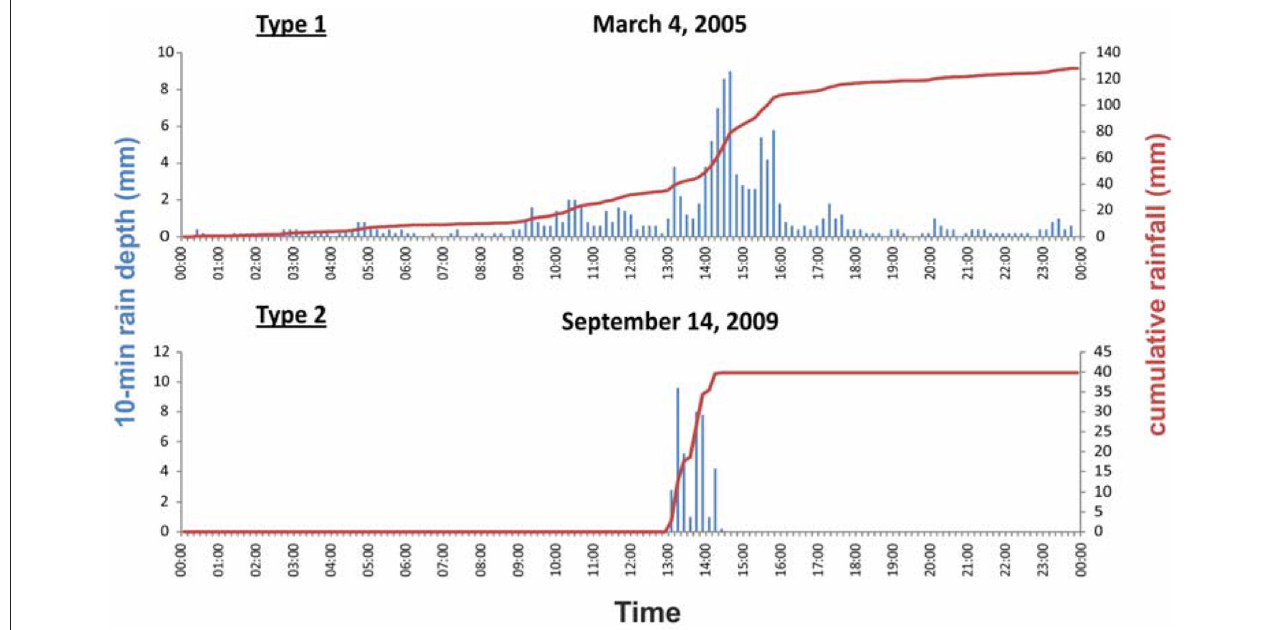
FIGURE 10 | Examples of the two types of rainfall recorded during flash flood